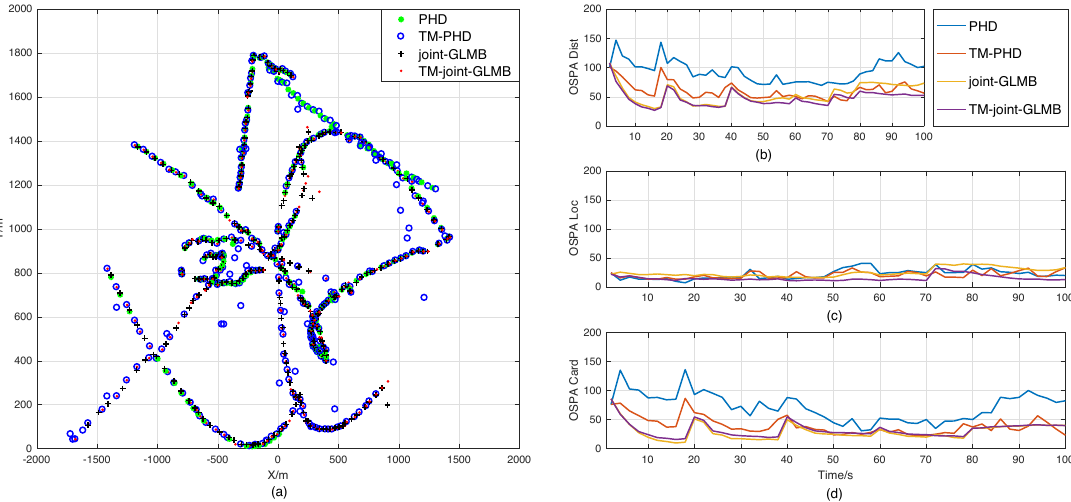
Figure 7. Result comparisons in Scenario 4. ( a ) Position estimations of the original RFS-based filters and the time-matching filters in one trial. ( b ) OSPA errors. ( c ) Location components of OSPA. ( d ) Cardinality components of